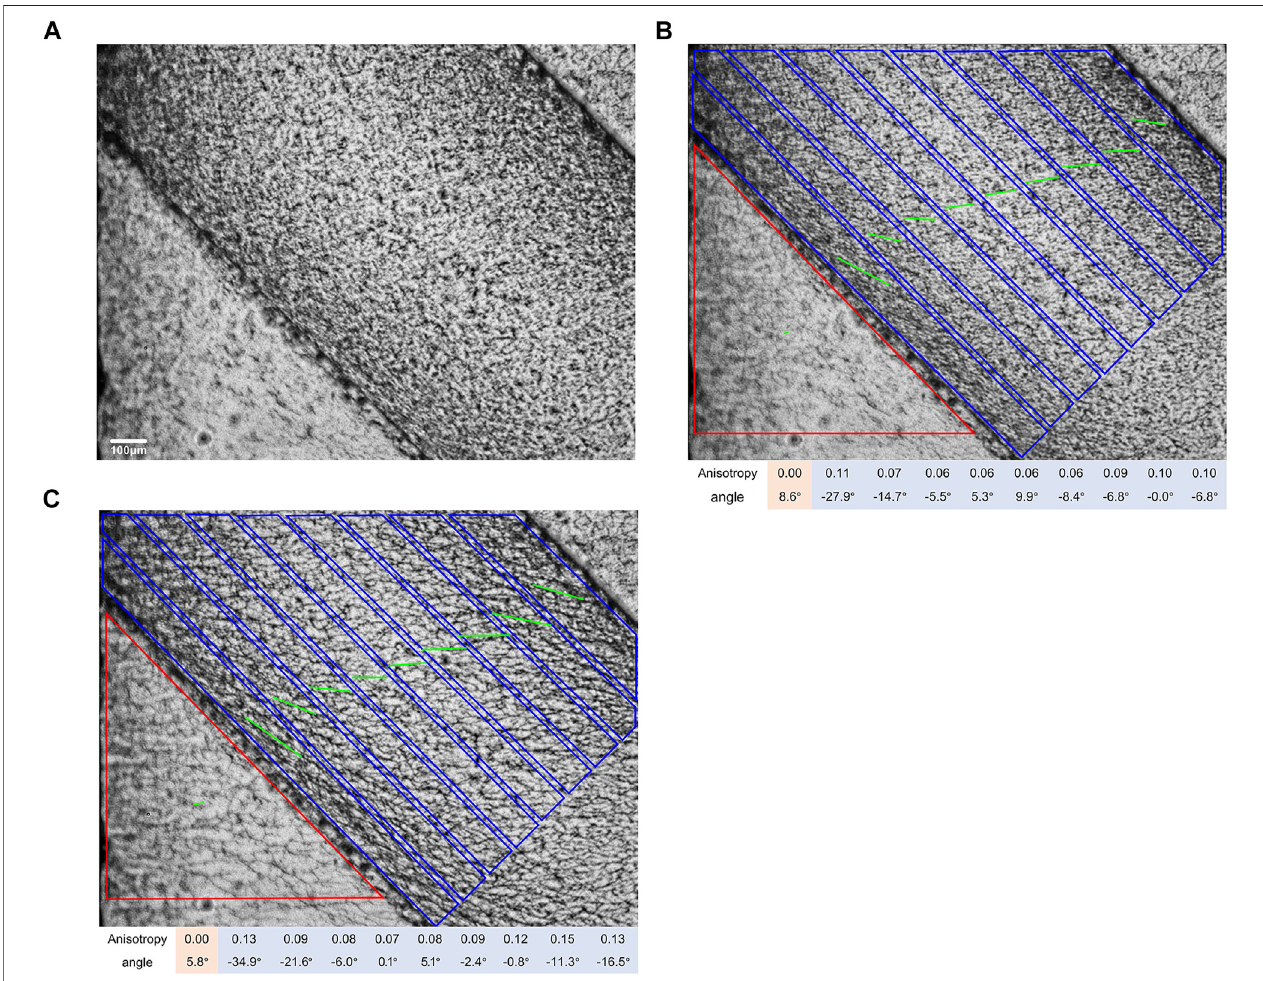
FIGURE 6 | Optical image near the interface of the setup in Figure 4 . (A) Initial time, (B) middle time, and (C) fi nal time. (B,C) are output from FibrilTool: a line segment (green) is drawn, the angle of which represents the average orientation of the array and the length of which is proportional to the array anisotropy, the polygon represents the region of